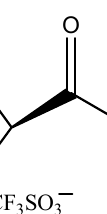
Figure 8. Structure of [ProH]CF 3 SO 3 [75].